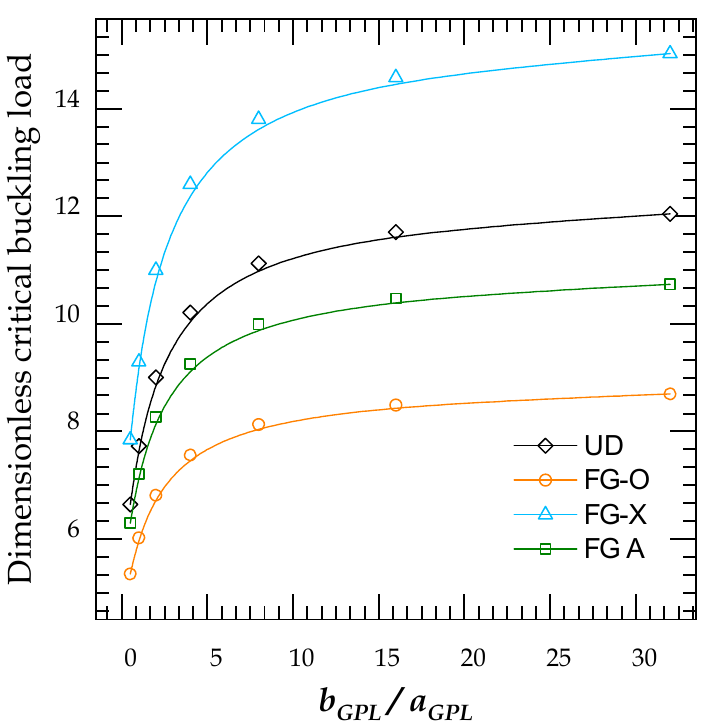
Figure 6. Dimensionless critical buckling load of simply supported GRNC plate versus the width-to-length ratio of the GPLs nanofillers (g (cid:2891)(cid:2900)(cid:2896)∗ = 1%, 𝑎